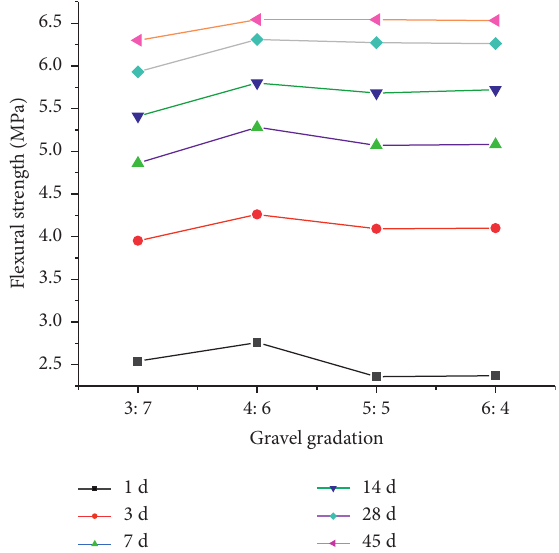
Figure 8: Influence of gravel gradation on concrete flexural